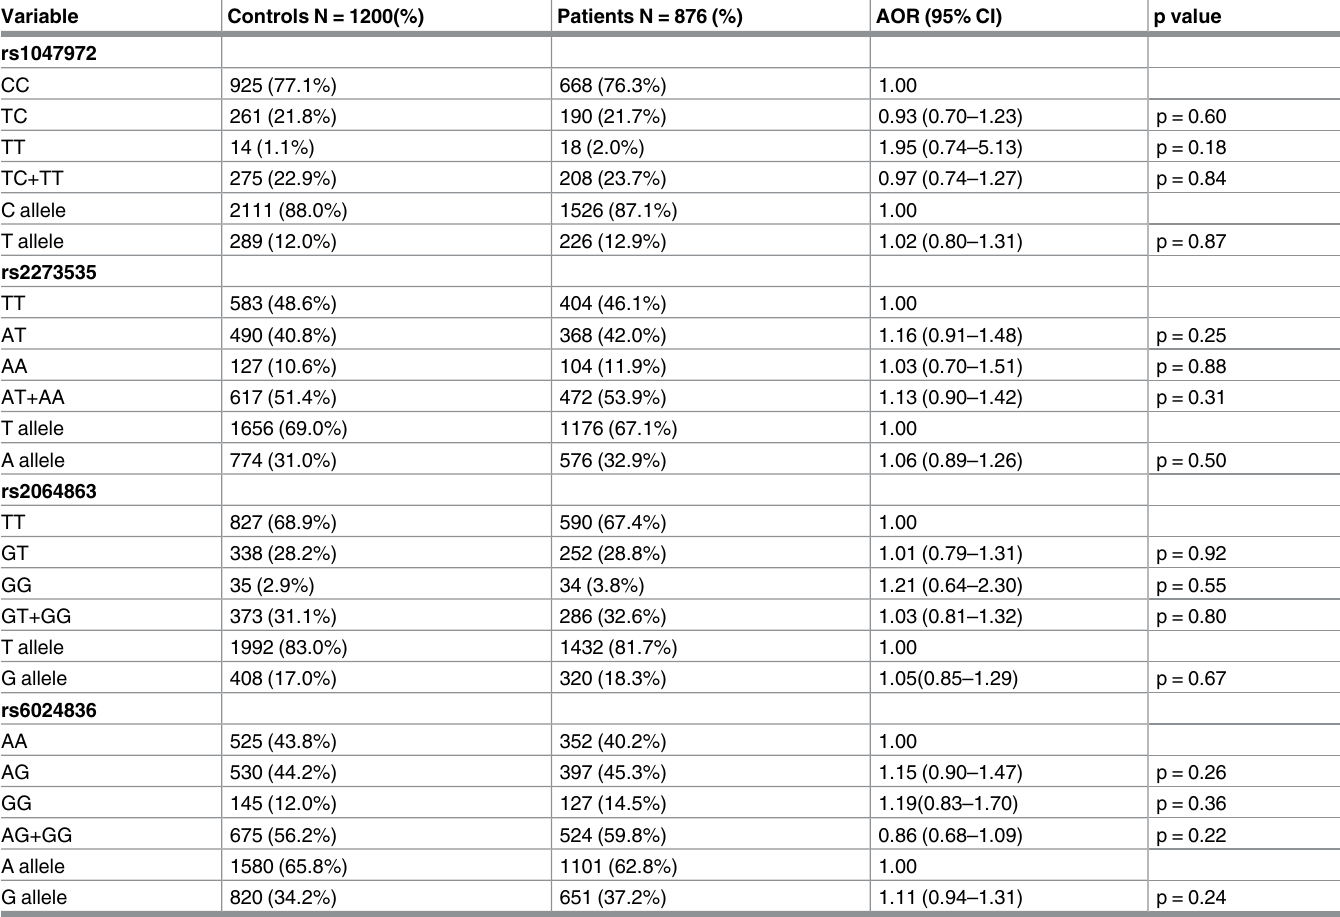
Table 2. Genotyping and allele frequency of AURKA single nucleotide polymorphism in oral cancer and normal controls.